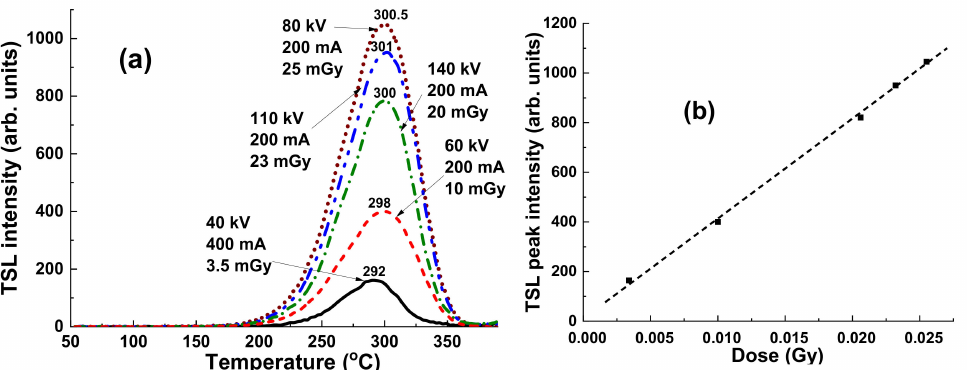
Figure 9. ( a ) Dependence of TSL peak intensity and peak position for YAG:Ce crystal sample on irradiation dose by continuous X-ray photons working with NAP in the 40–140 KV range and current in the 200–400 mA range; ( b ) TSL intensity as a function of the dose of irradiation for the YAG:Ce crystal